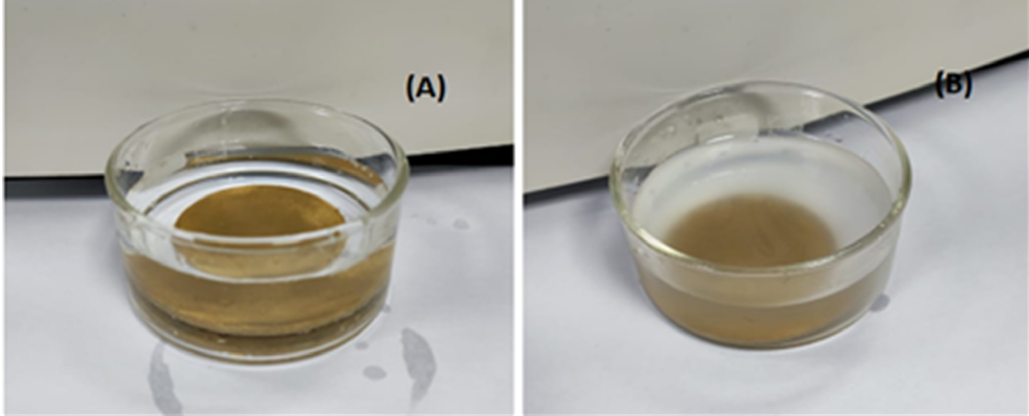
Figure 9. ( A ) M0.5 immersed in seawater ( B ) M0.5 immersed in o/w emulsion with higher oil concentration of 2 g/L.